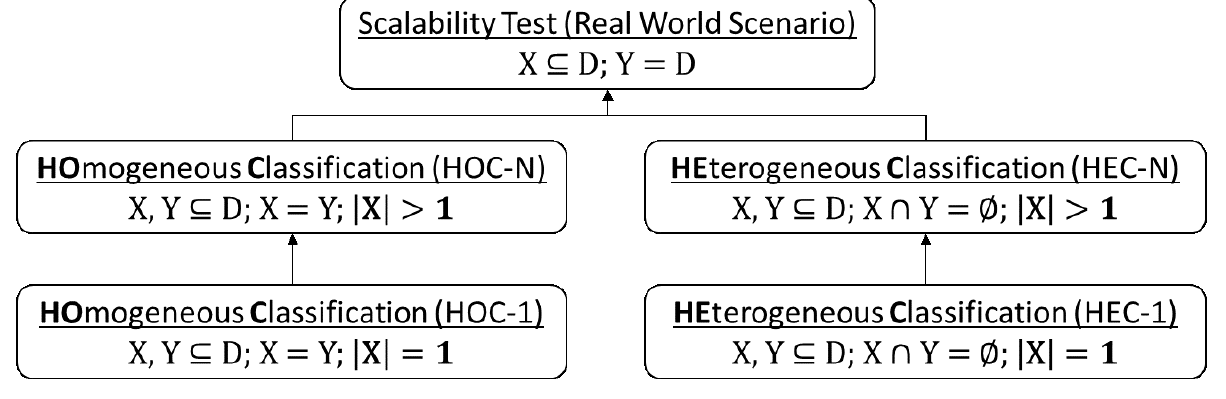
Figure 3. Overview of evaluation strategies for the personal health status mention classifier. Note, D={d1, d2, …, dn} is set of health issues, X is set of health issues selected to train classifier, and Y is set of health issues used to test